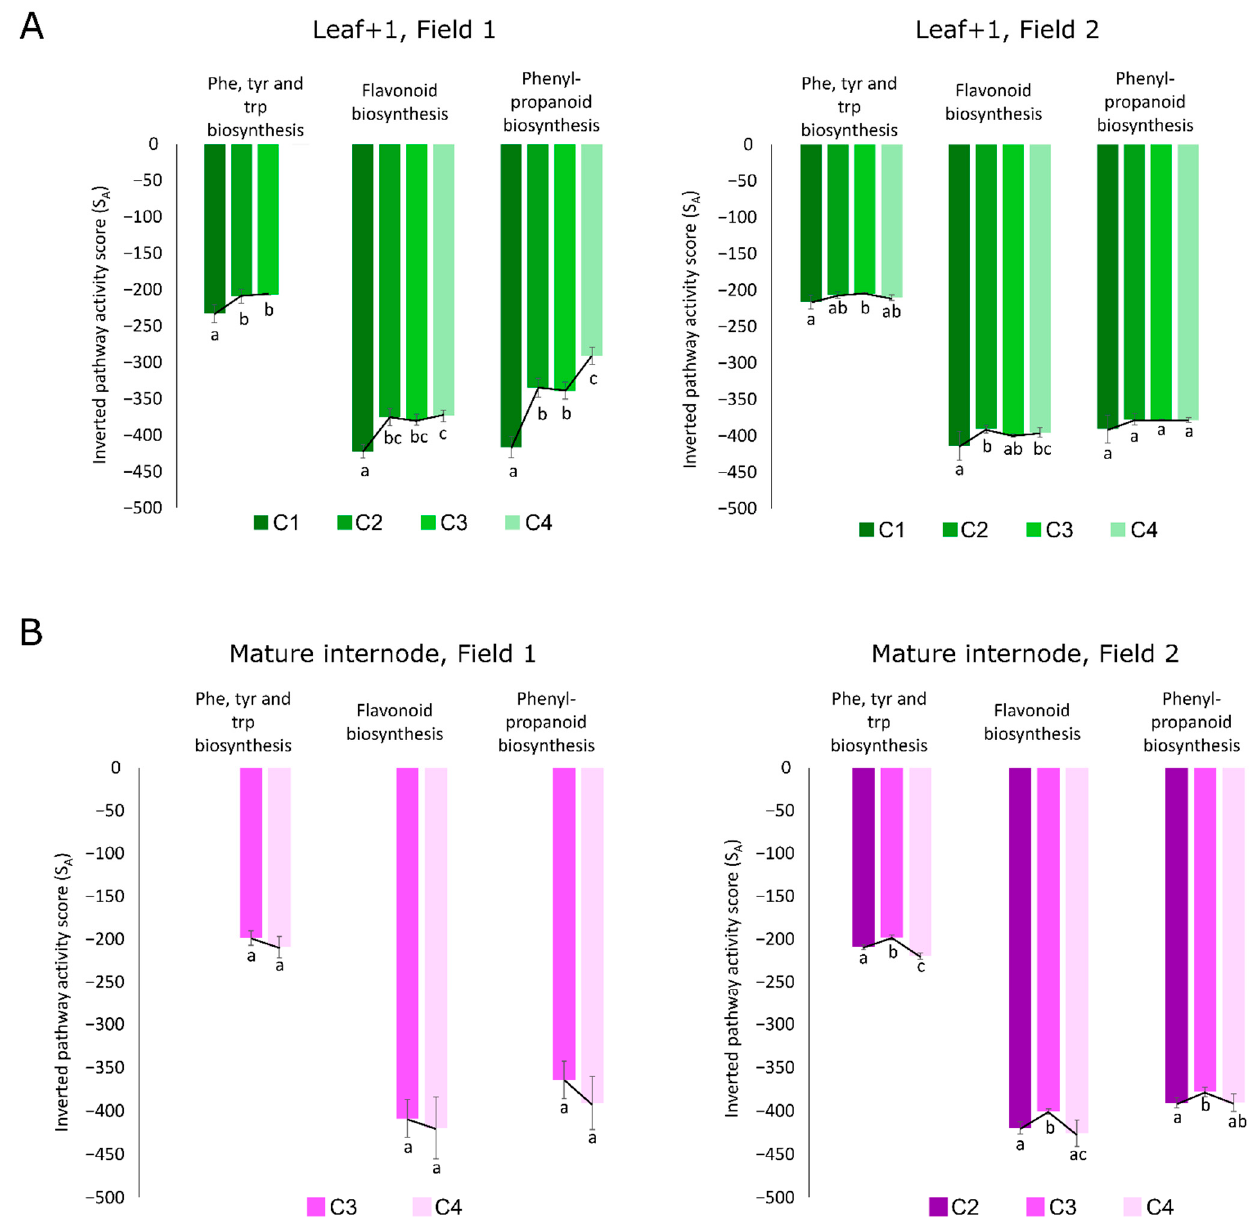
Figure 8. Pathway activities from the phenylalanine, tyrosine and tryptophan biosynthesis, flavonoid biosynthesis and phenylpropanoid biosynthesis. Pathway activities based on the pathway activity profiling (PAPi) tool of ( A ) leaves (L1) from F1 and F2; and of ( B ) mature internodes (I9) from F1 and F2. C1, C2, C3, and C4 refer to sampling points 1, 2, 3 and 4 specifically 4, 8, 11 and 13 months after planting. Bars with different letters (i.e., ‘a’ and ‘b’) indicate statistically significant differences between their activity scores based on ANOVA and Fisher’s LSD ( p < 0.05) and bars with the same letters (i.e., ‘a’ and ‘a’) do not have activity scores statistically different.